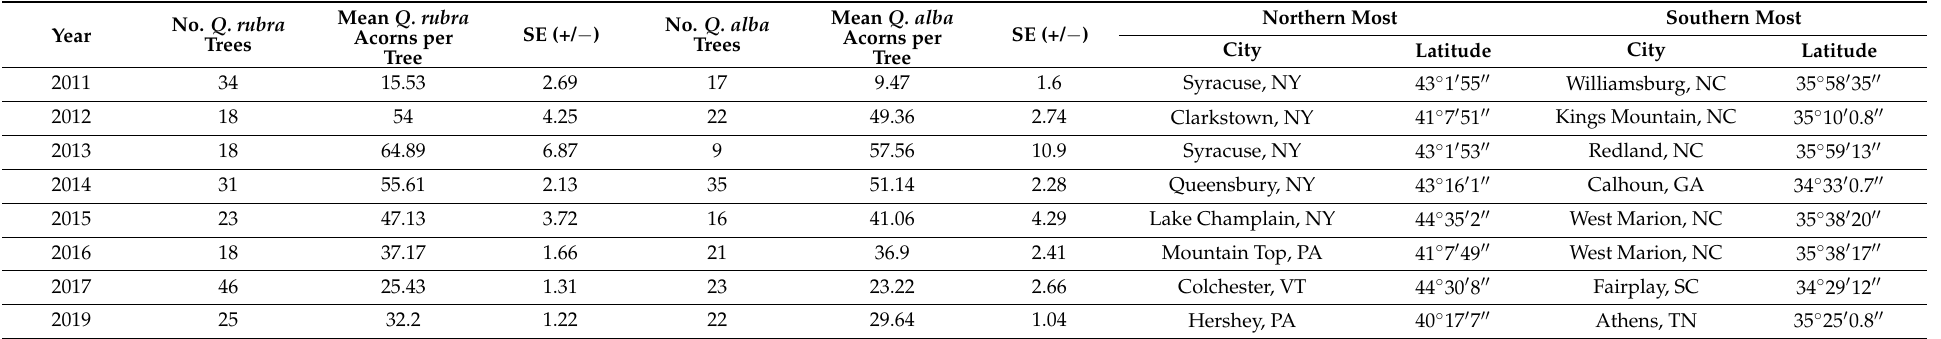
Table 1. Summary of number of trees and acorns (mean ± SE) of red oak (RO, Q. rubra ) and white oak (WO, Q. alba ) sampled and analyzed for weevil infestation along latitudinal gradients over an eight-year period. Additionally, shown are the northern- and southern-most latitudes (and nearest major city) for each year of